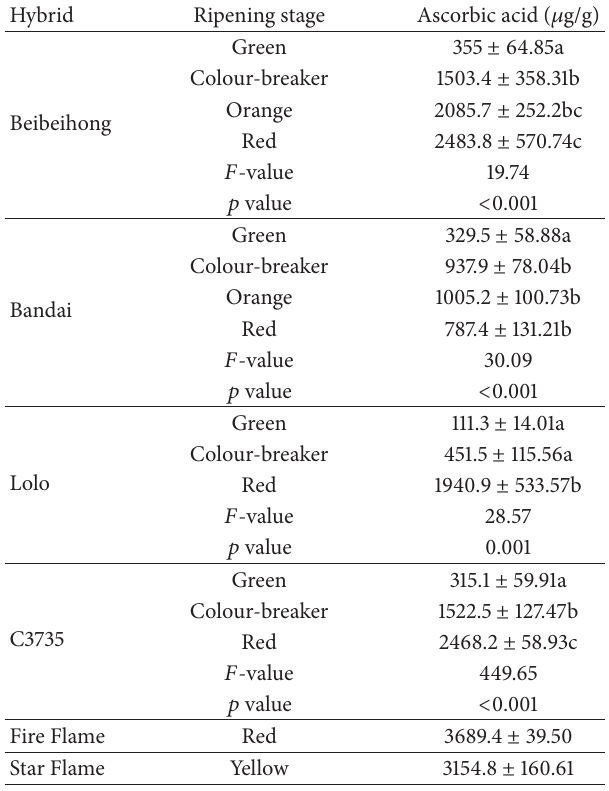
Table 4: Change in content of ascorbic acid in different chili hybrids as a function of ripening. The values represent means in 𝜇 g/g fresh weight base ± standard deviation ( 𝑛 = 3